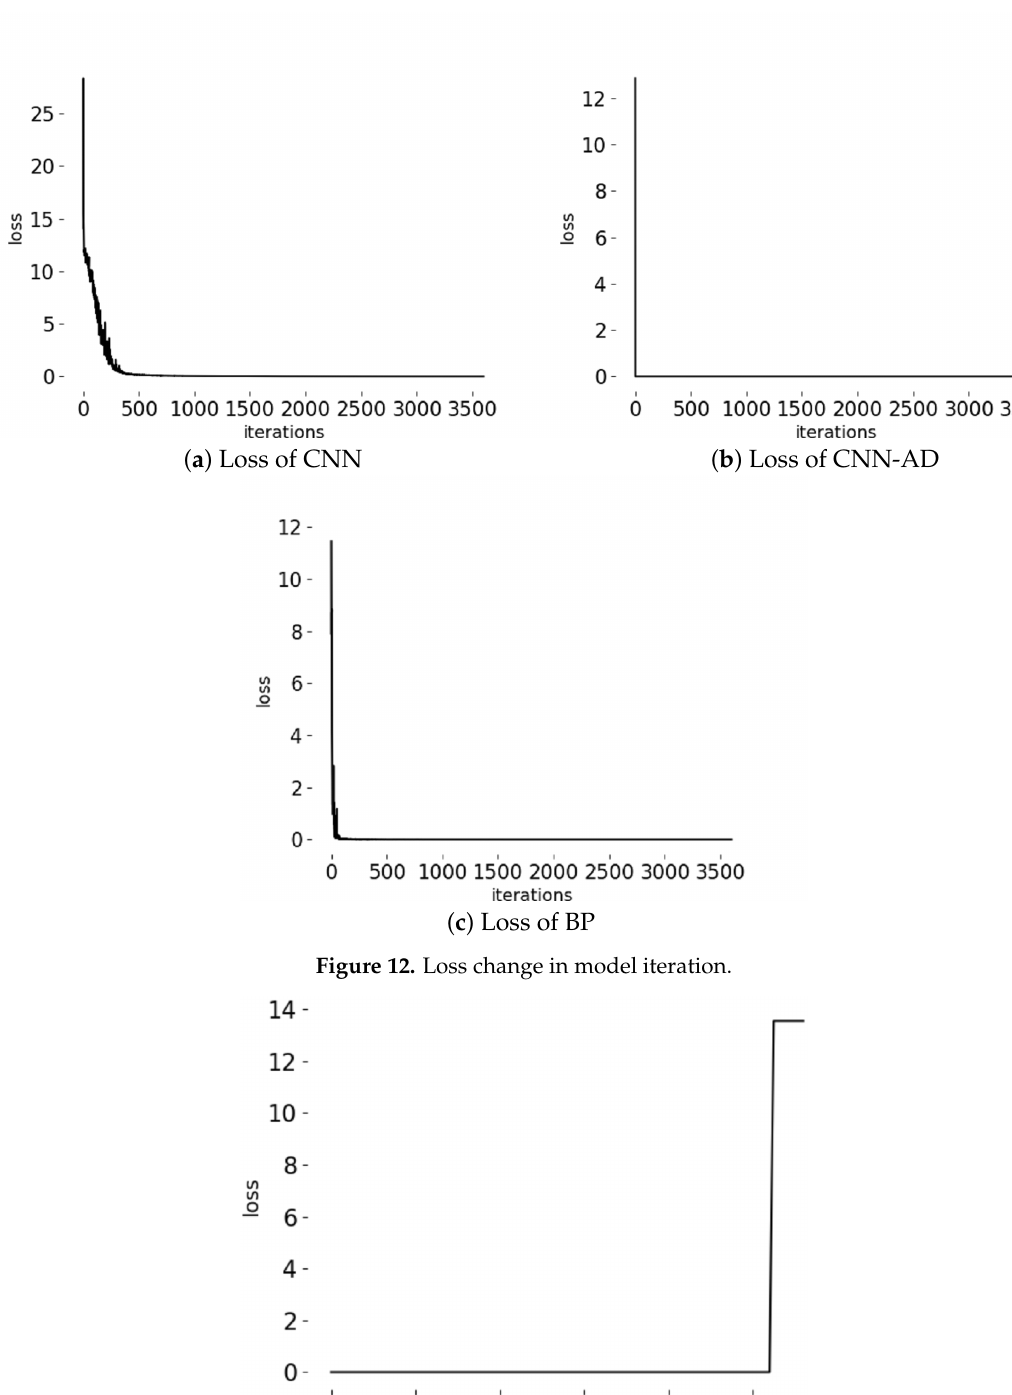
Figure 13. Loss of CNN-AD in test stage, the sudden rise of loss value is the moment of tool